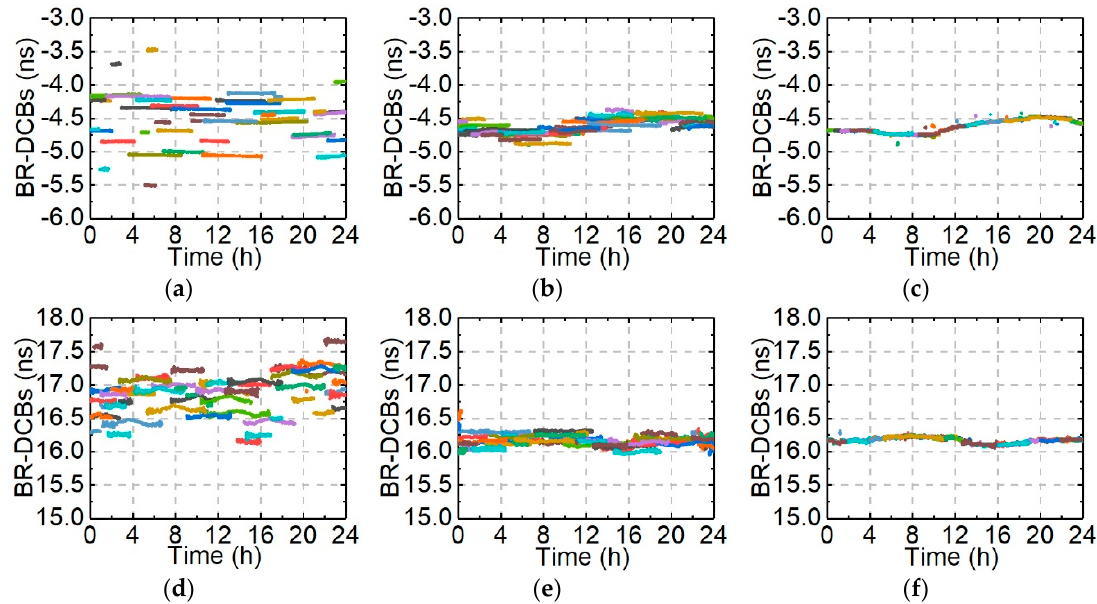
Figure 4. Single difference ionospheric observable called BR-DCB retrieved from zero (KOKB-KOKV, Figure 4. Single di ff erence ionospheric observable called BR-DCB retrieved from zero (KOKB-KOKV,